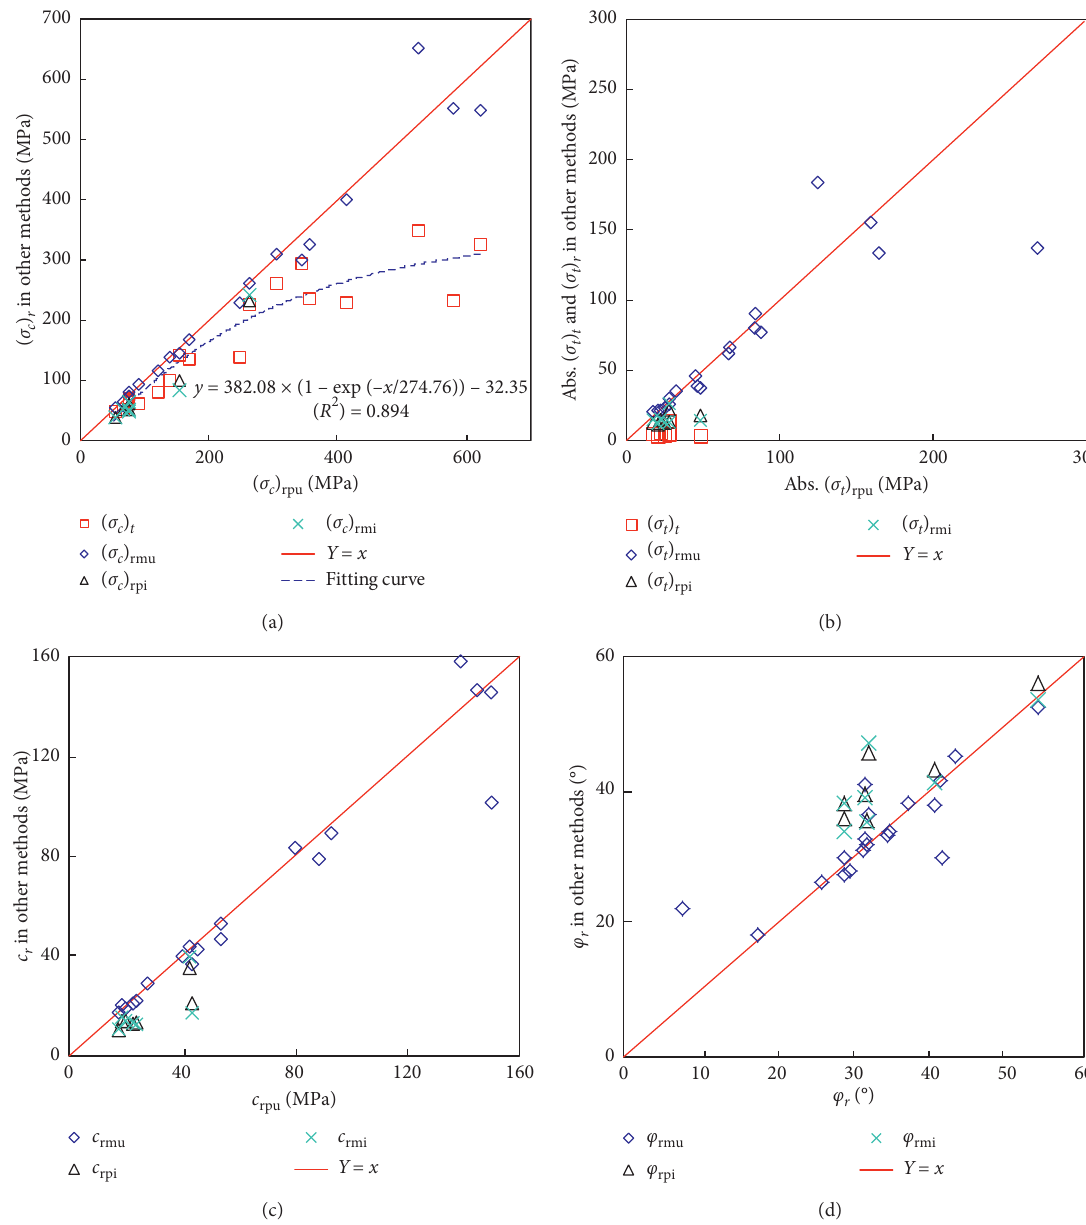
Figure 4: ( σ c ) r , ( σ t ) r , c r , and φ r predicted by regression of equation (1) in two stress spaces. (a) ( σ c ) r . (b) ( σ t ) r . (c) c r . (d) φ r